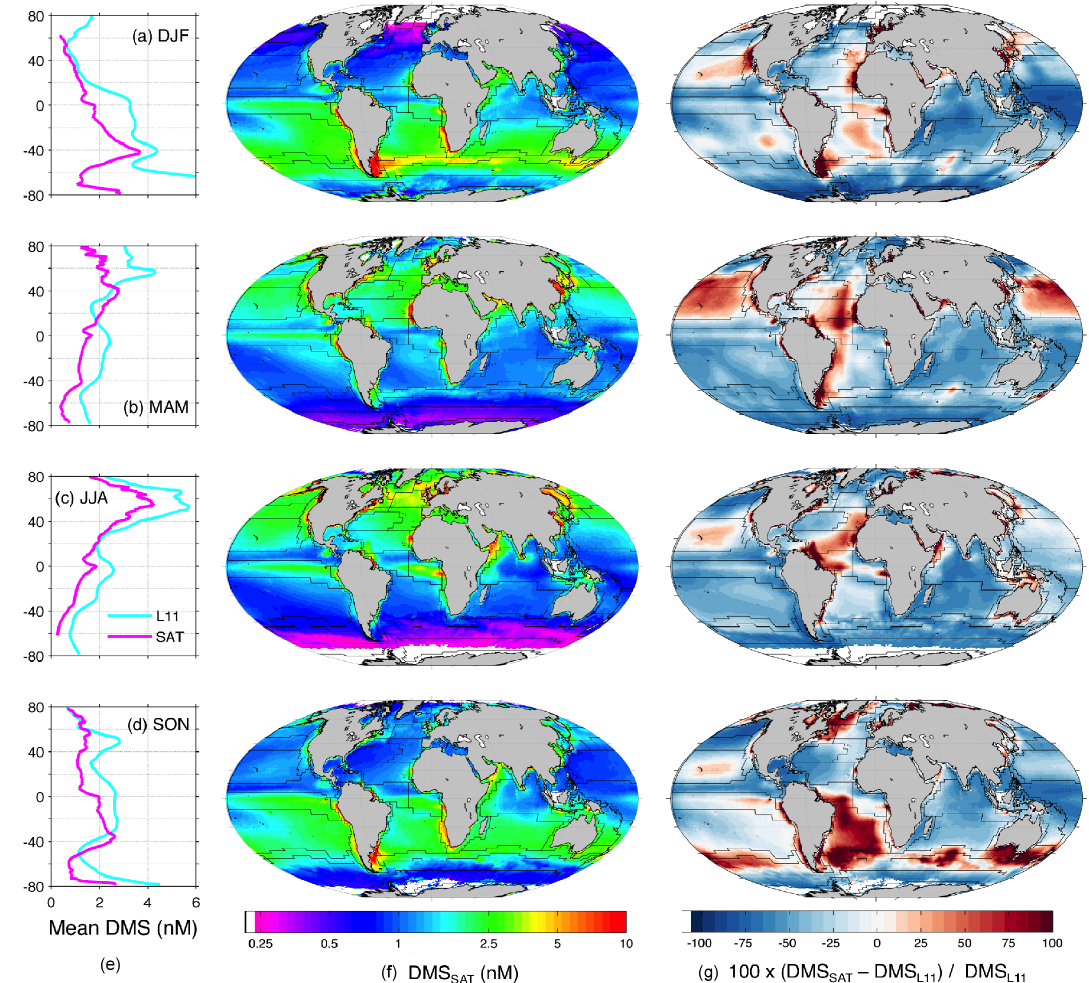
Figure 5. Global DMS SAT concentration fields by season. (a) December–February (DJF); (b) March–May (MAM); (c) June–August (JJA); (d) September–November (SON). Each row contains mean latitudinal profiles for the L11 climatology and DMS SAT (left); DMS SAT con- centration maps (center); and maps of the percentage difference between DMS SAT and the L11 climatology (right).